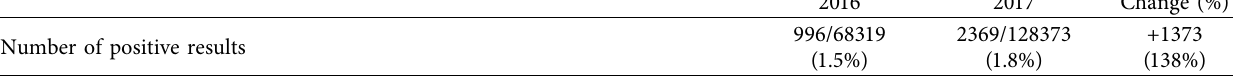
Number of positive results of screening tests performed on admission Number of positive results of screening tests performed after 48hours of